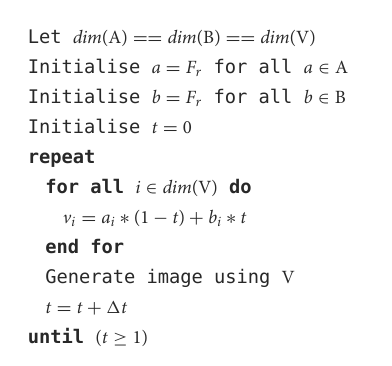
Algorithm 2. Updating the input vector - Second